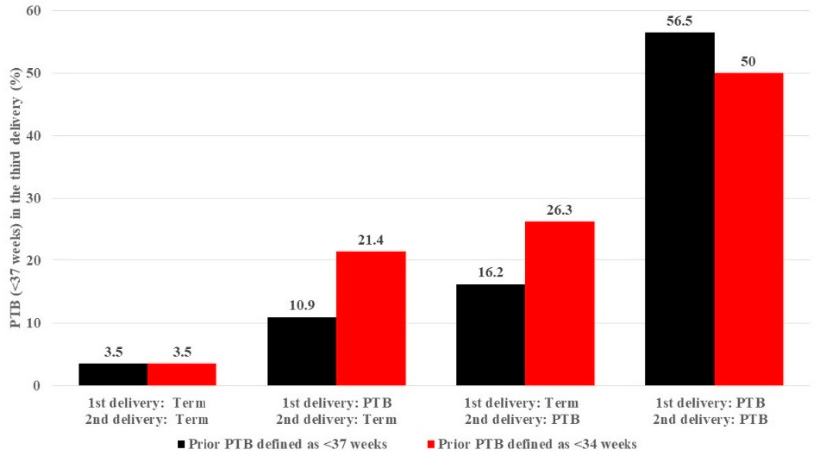
Figure 2. The rate of preterm birth (PTB) at the third delivery stratified by the number and gestational age of prior preterm births.